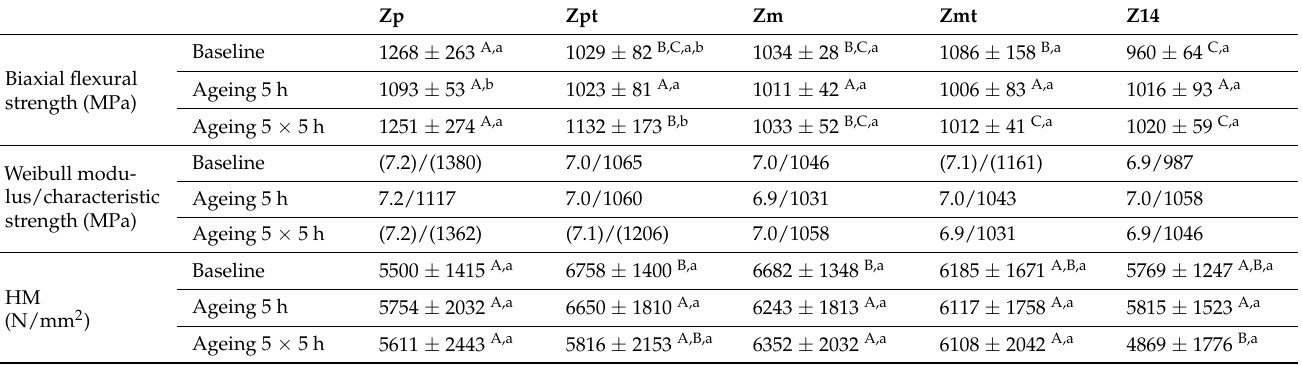
Table 2. Mechanical properties of zirconia with different surface treatments (Zp, Zpt, Zm, Zmt, and Z14). The values are presented using mean and standard deviations for biaxial flexural strength and Martens hardness